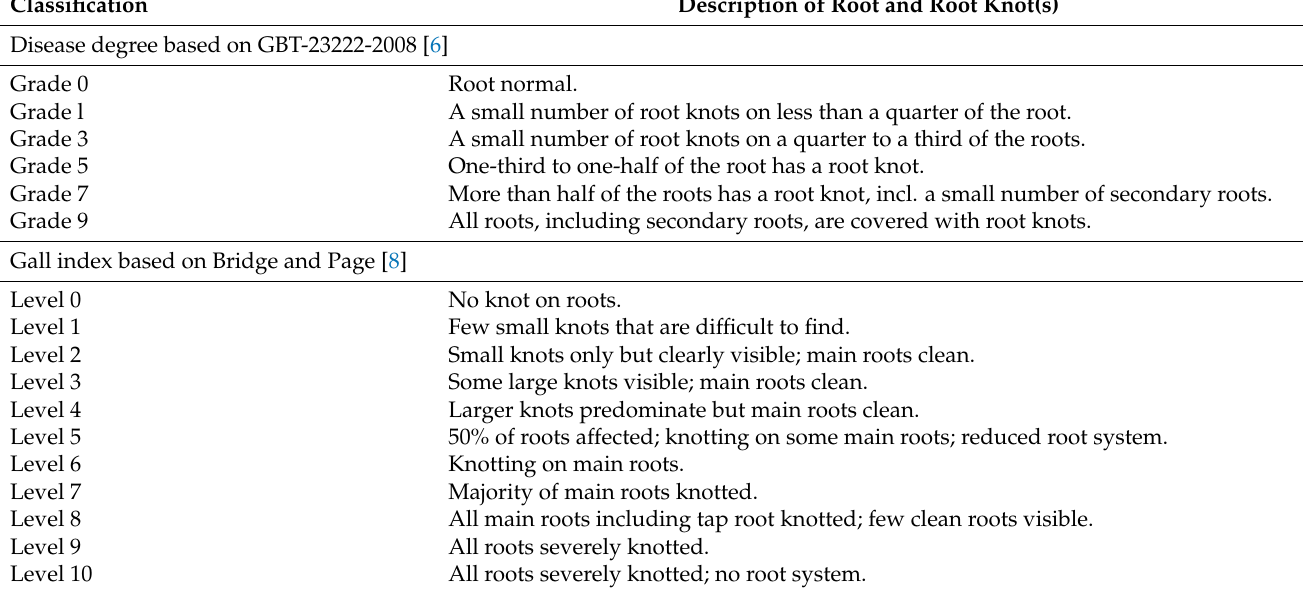
Table 2. Classification criteria for the nematode disease degree based on the Chinese National Standard GBT-23222-2008 and the gall index based on the method described by Bridge and Page (see also Figure